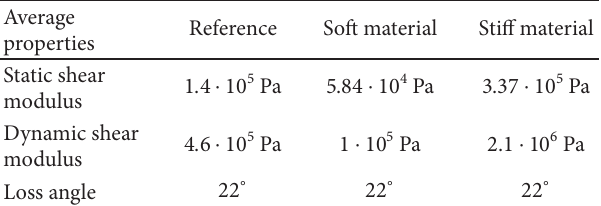
Table 4: Viscoelastic material properties of the reference and soft and stiff material models.